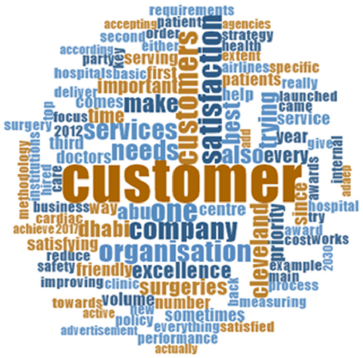
Figure 1. Word cloud depicting organizational objectives.